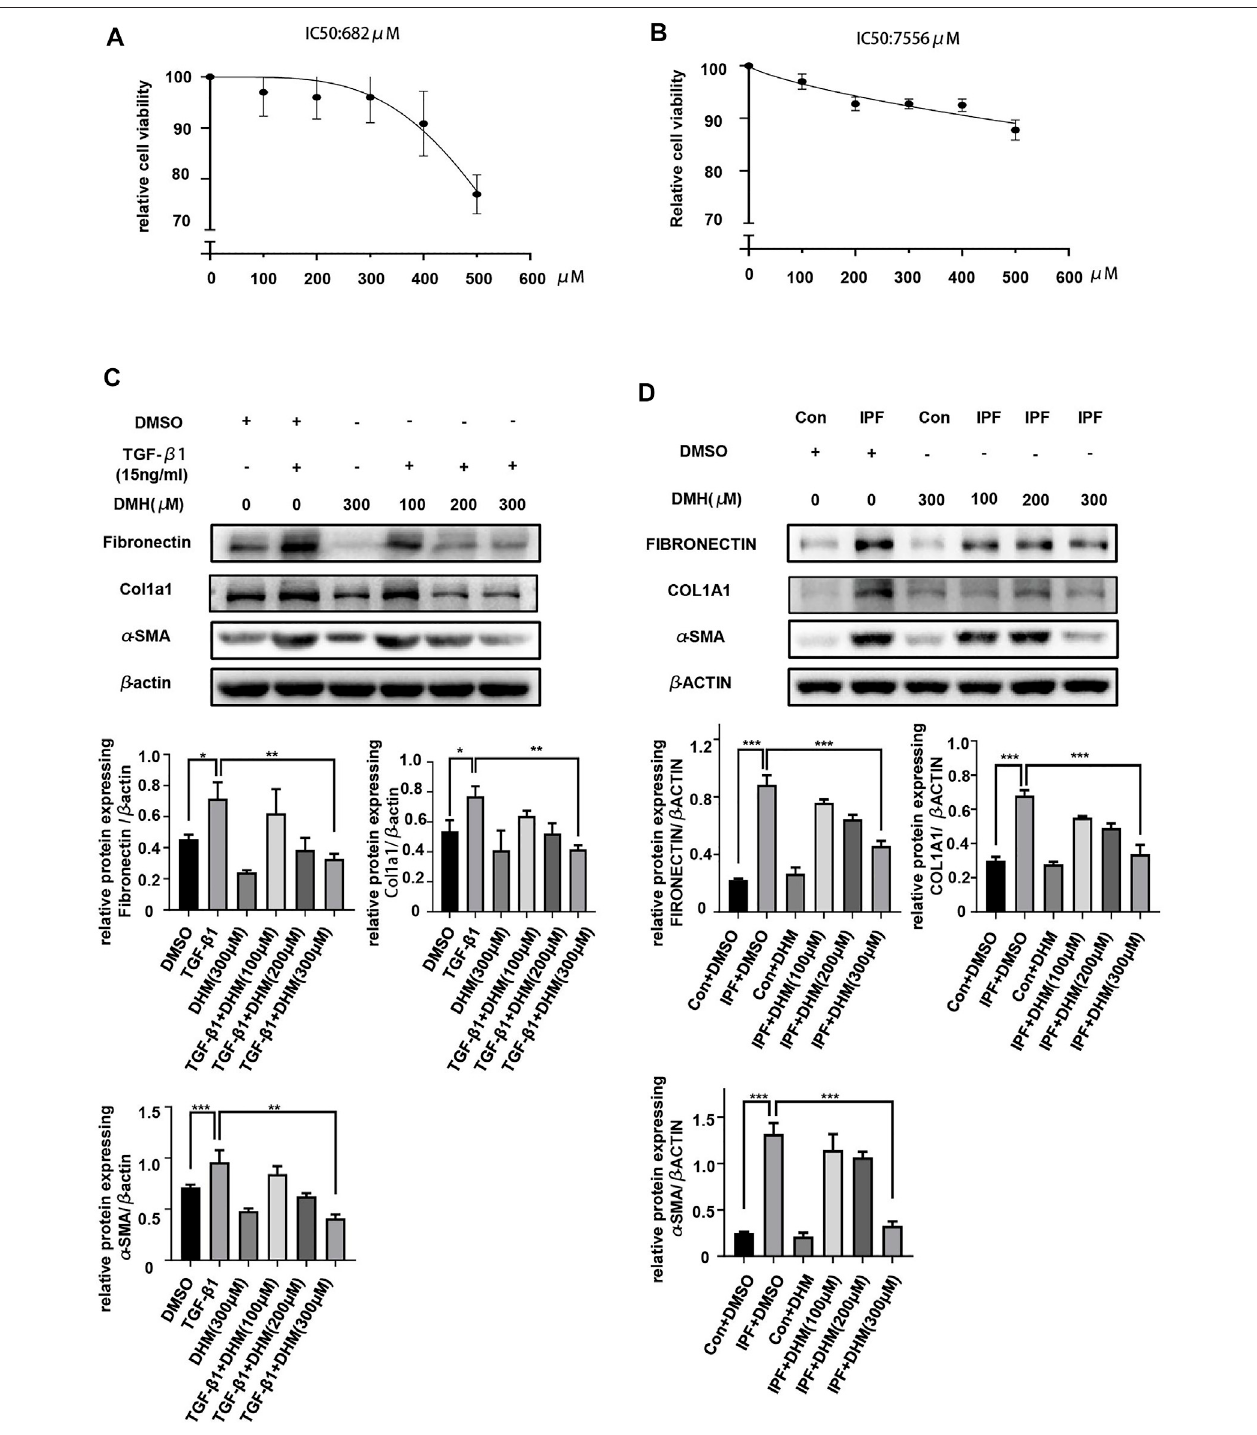
FIGURE 2 | Effects of DHM on the differentiation of fi broblasts. (A) Toxicity detection of DHM on PHLFs by the CCK-8 assay ( n = 6). (B) Toxicity detection of DHM on PMLFs bythe CCK-8 assay ( n = 4). (C) Westernblotting analysis of fi bronectin, Col1a1, and α -SMA in PMLFs treated with DHM ( n = 5). (D) Westernblotting analysis of fi bronectin, COL1A1, and α -SMA expression in PHLFs treated with DHM ( n = 5). The data are represented as the mean ± SD of three independent experiments. Ordinary one-way ANOVA analysis was applied. *, p < 0.05; **, p < 0.01; ***, p < 0.001.